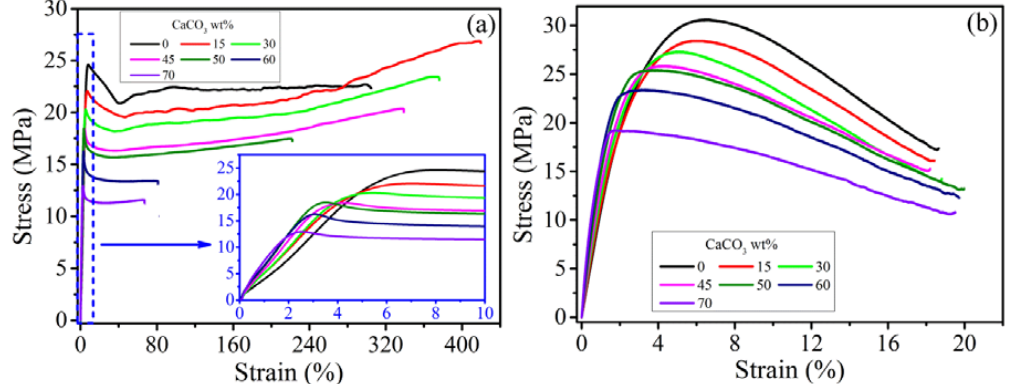
Figure A2. Typical ( a ) tensile and ( b ) bending stress-strain curves of different contents PP/CaCO 3 composites.